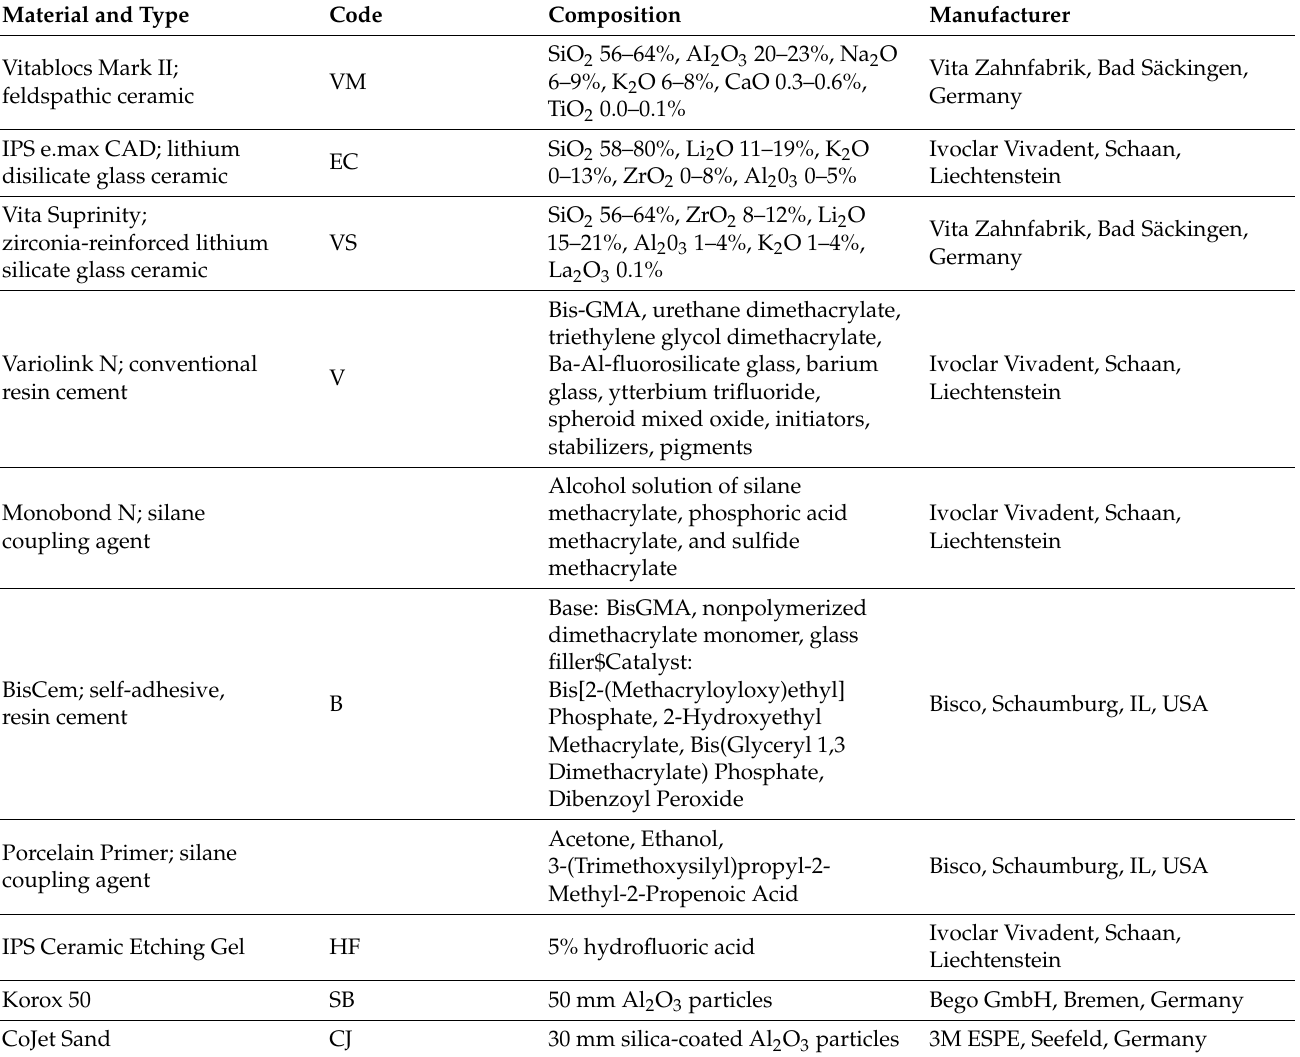
Table 1. Materials used in the